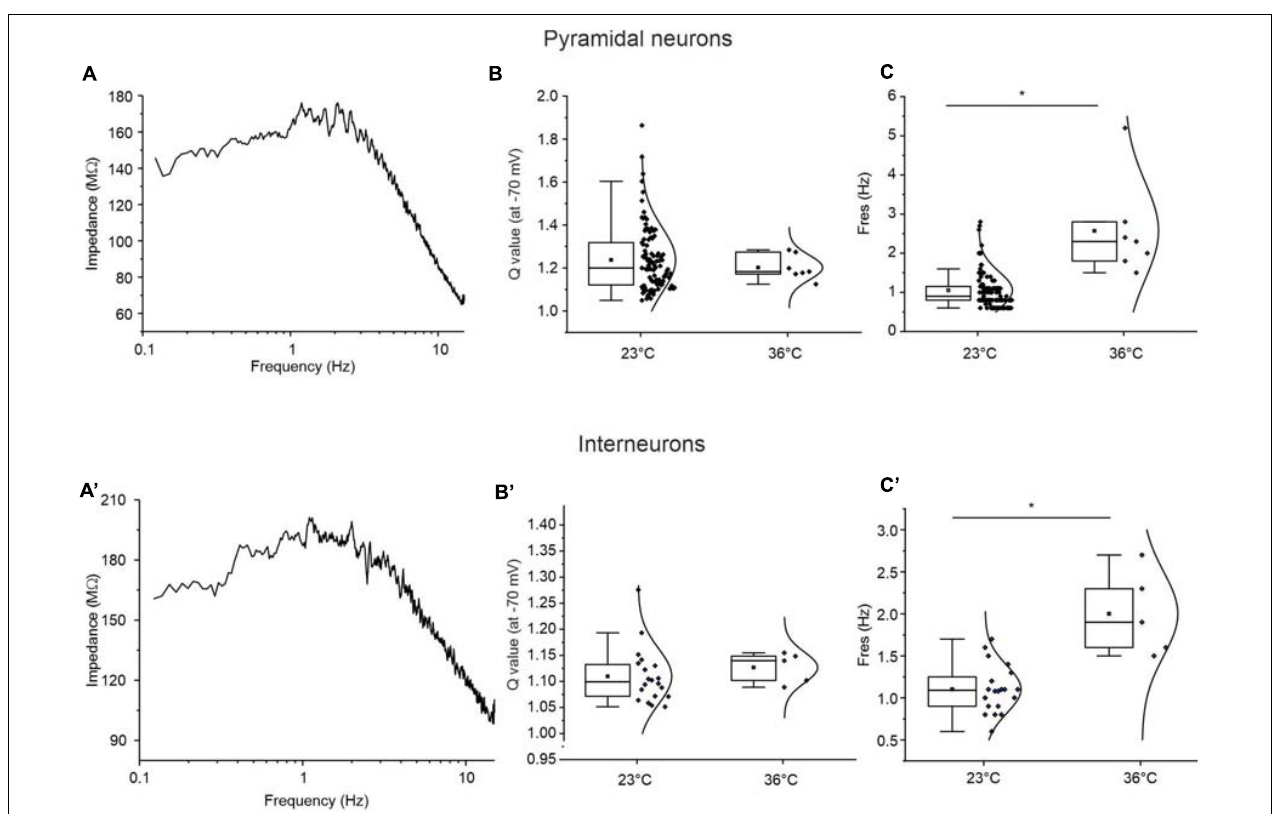
FIGURE 10 | Effect of temperature on the resonance properties of pyramidal neurons (A–C) and GABAergic interneurons (A (cid:48) –C (cid:48) ) of the PRC. (A) Impedance-to-frequency relationship obtained from a representative resonant pyramidal neuron at a temperature of 36 ◦ C by applying the standard 0–15 Hz ZAP protocol at –70 mV. (B,C) All-points half-violin plots flanked by summary box plots comparing the Q -values (B) and F res values (C) derived from resonant pyramidal neurons at room temperature (23 ◦ C) and at physiological temperature (36 ◦ C). The increase of temperature in the 7 pyramidal neurons tested at 36 ◦ C has no influence on the Q -value (B) , while determines a significant increase of F res (C) . (A (cid:48) –C (cid:48) ) Same as (A–C) for resonant GABAergic interneurons ( N = 5). Note that also in this cell type, the temperature increase does not alter the Q -value (B (cid:48) ) , while determines a significant increase of the F res (C (cid:48) ) . Data in (B,C,B (cid:48) C (cid:48) ) were compared by unpaired Student’s t -test. * p <